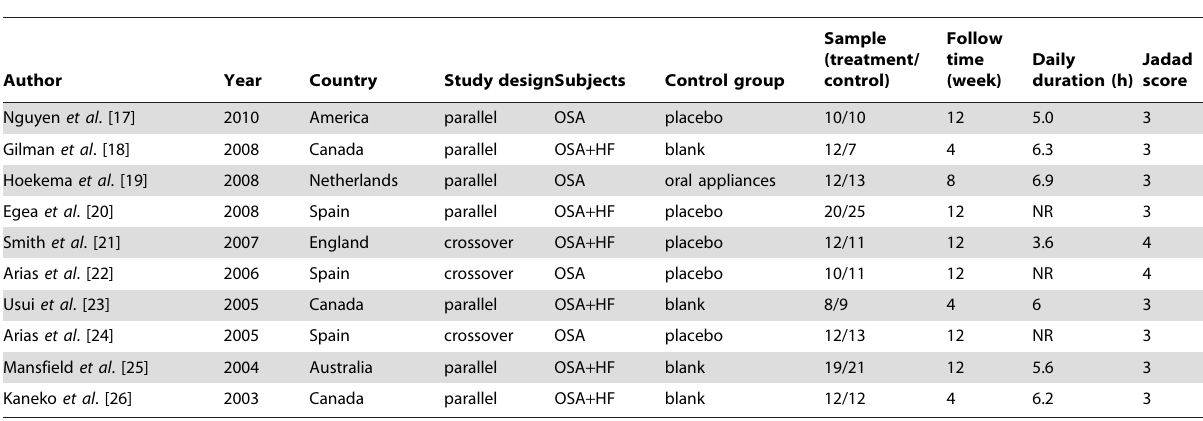
Table 1. Characteristics of 10 studies included in the meta-analysis.